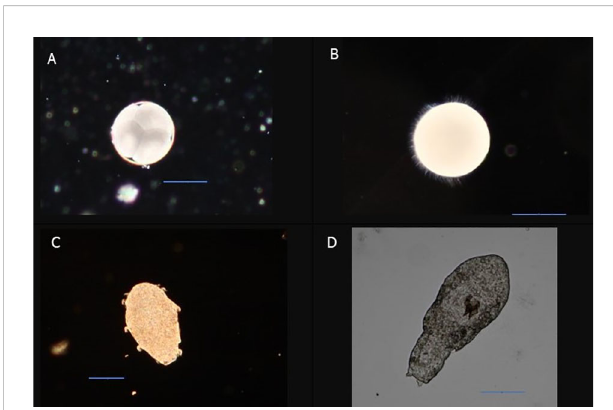
FIGURE 7 Developmental stages of fertilized eggs. (A) Egg with cell division. (B) Circular rotating stage prior to free-swimming gastrula. (C) Metatrochophore stage with ciliated bands. (D) Free-swimming larvae stage without chaetigers but with clearly visible jaws. Scale bar represents 100